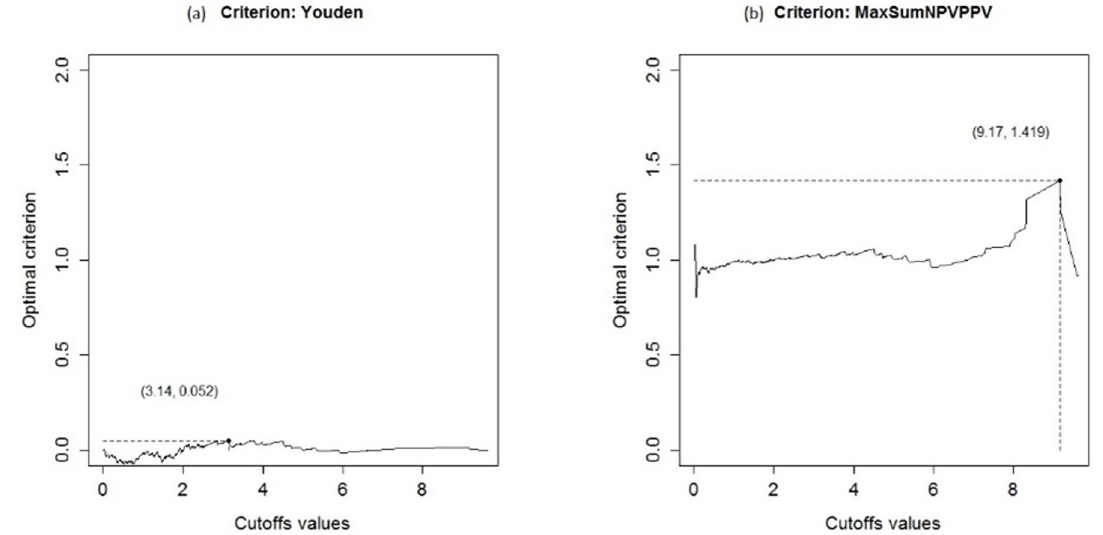
Fig 2. The receiver operating characteristic (ROC) curve of the participants in this